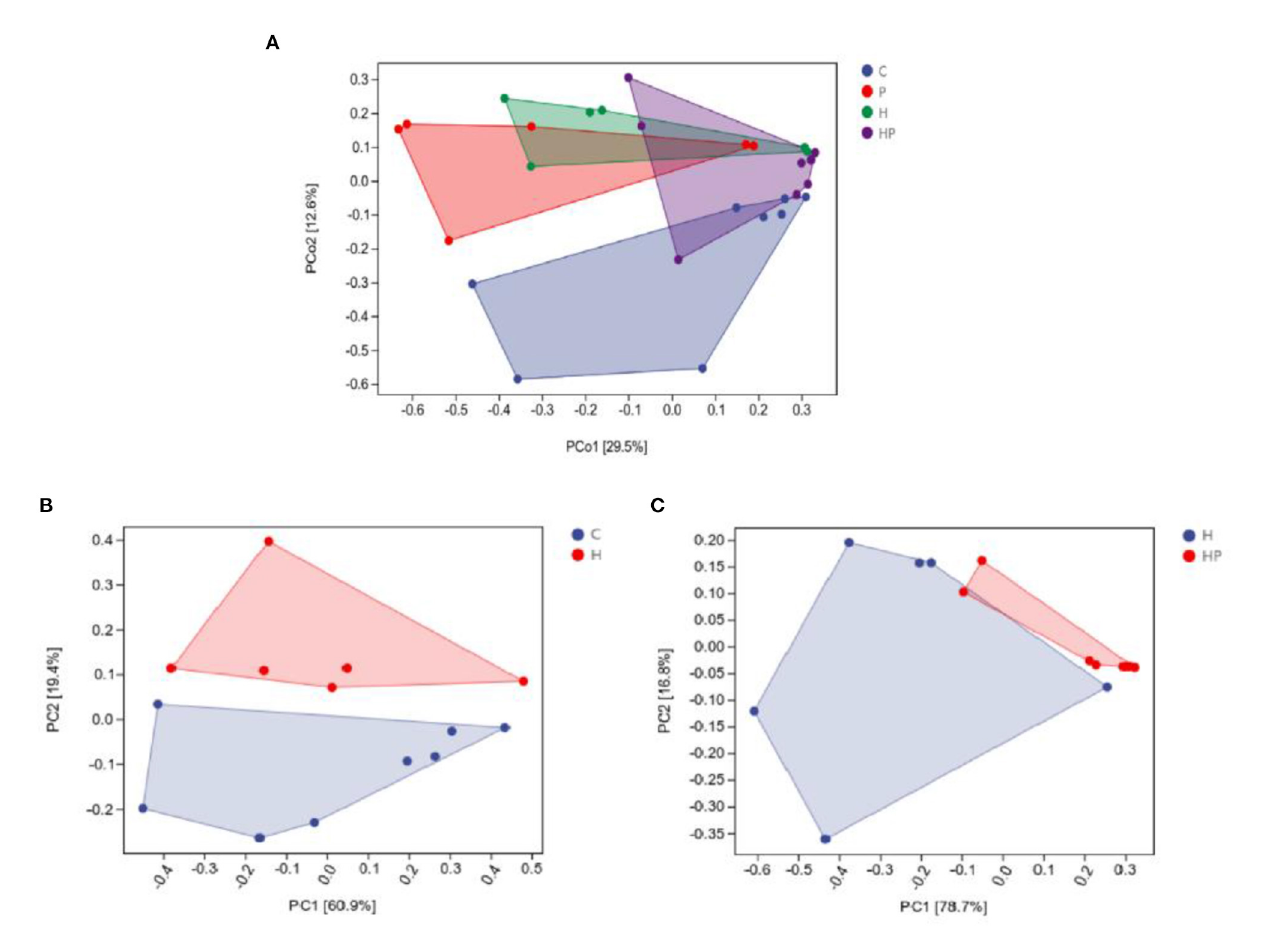
FIGURE3 Principal coordinate analysis (Bray-Curtis dissimilarity) score plot of gut microbiota of the zebrafish fed on four different groups (A) , on C and H group (B) , and on H and HP group (C) .